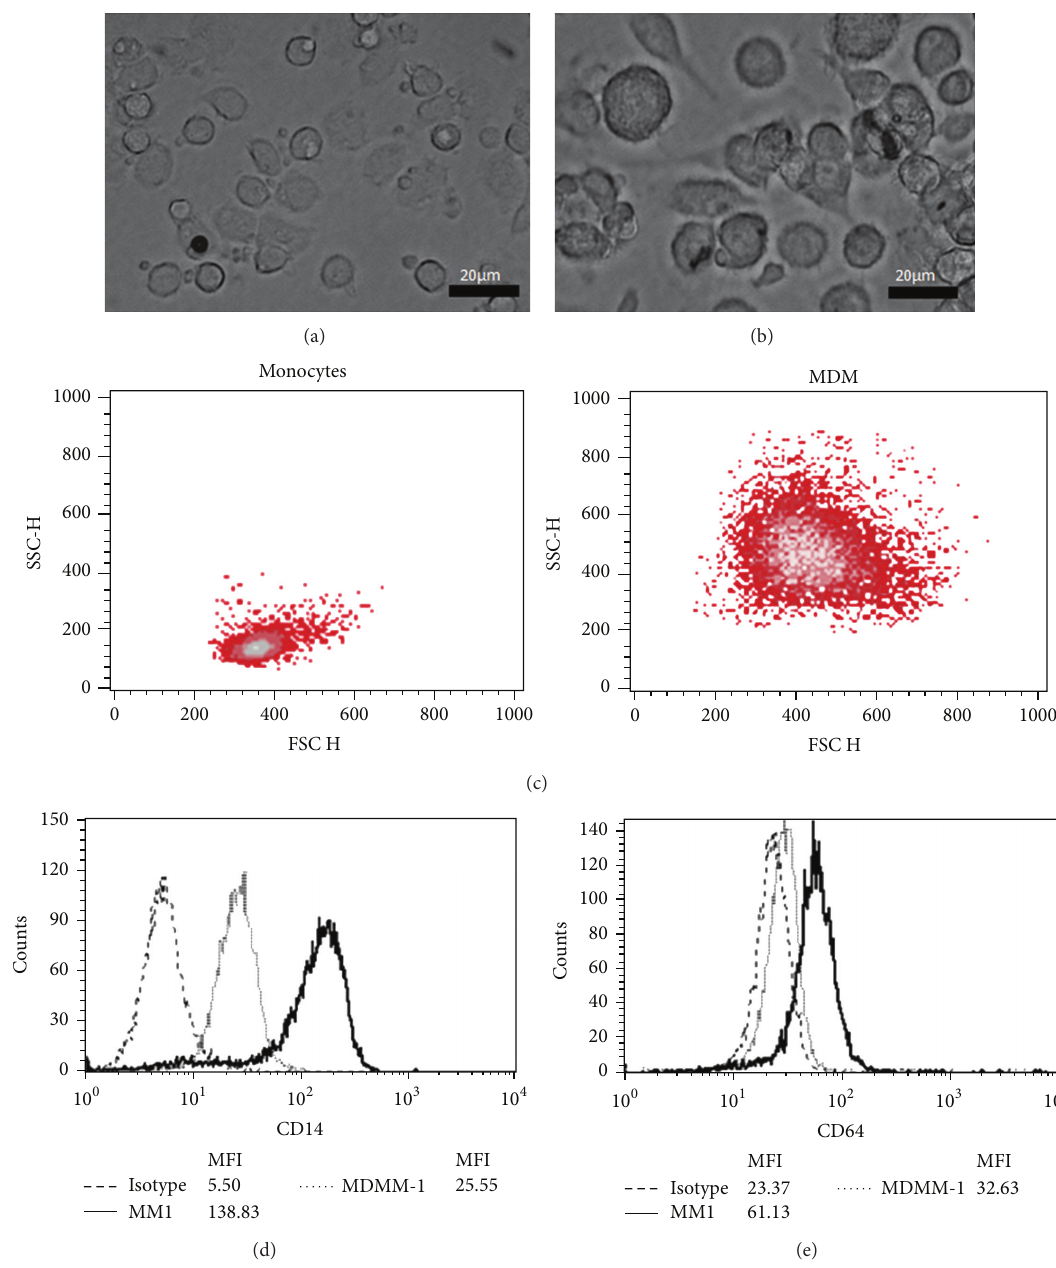
Figure 2: Differentiation of freshly isolated blood monocytes into MDMs. Representative interferential contrast images of blood monocytes (a) and MDMs (b) after 8 days of differentiation in culture, as well as forward light scatter and side light scatter plots (c). CD14 (d) and CD64 (e) expression was analyzed by flow cytometry before and after differentiation. Data shown are representative of three